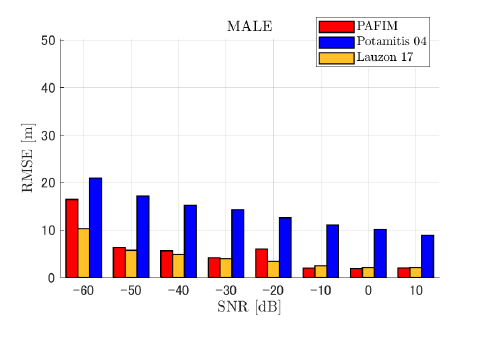
Figure 13. RMSE of tracking a sound source moving in a circle emitting male voice (focusing on source horizontal distance = 30 m).